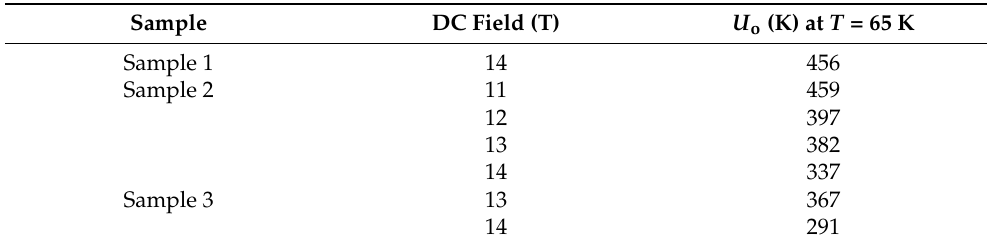
Table 2. Values of pinning potential estimated from slopes b , in various DC higher magnetic fields, at 65